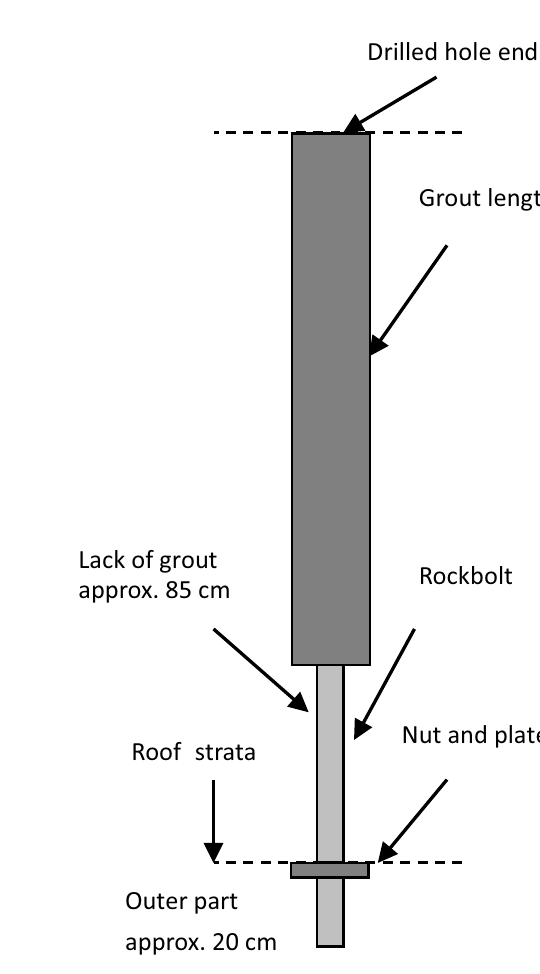
s 2 )/N, the horizontal axis—frequency, in Hz and the scatter plot of the differences between FE model and data evaluated experimentally. The geometry of lack of grout is also presented